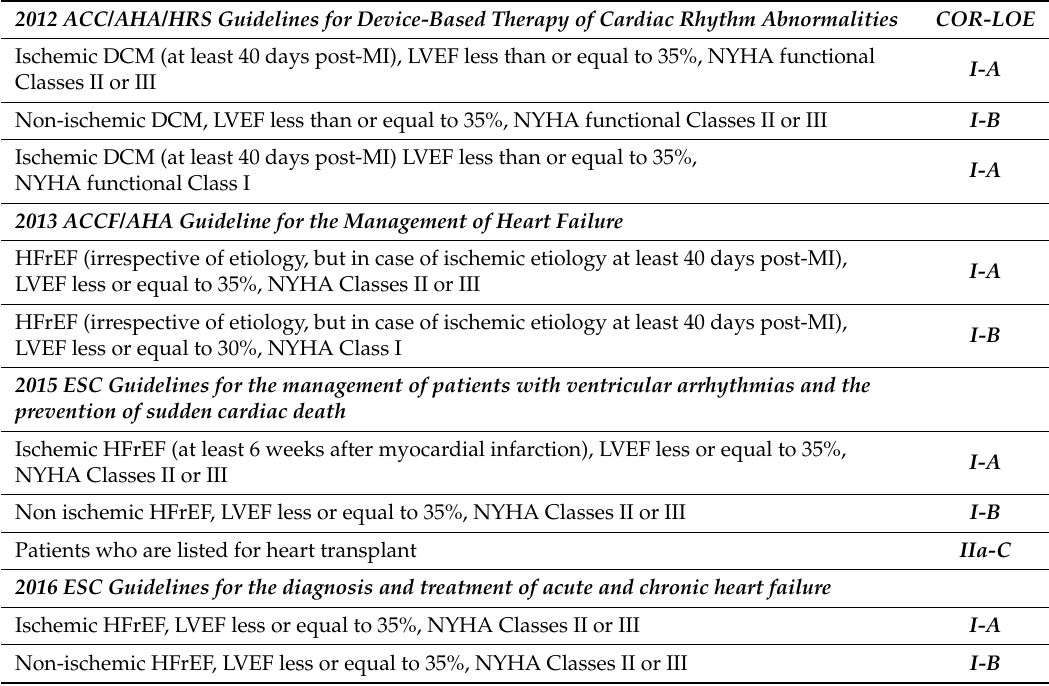
Table 2. Indication to ICD implantation in HF patients. COR: Class of Recommendation. 2012 ACC/AHA/HRS Guidelines for Device-Based Therapy of Cardiac Rhythm